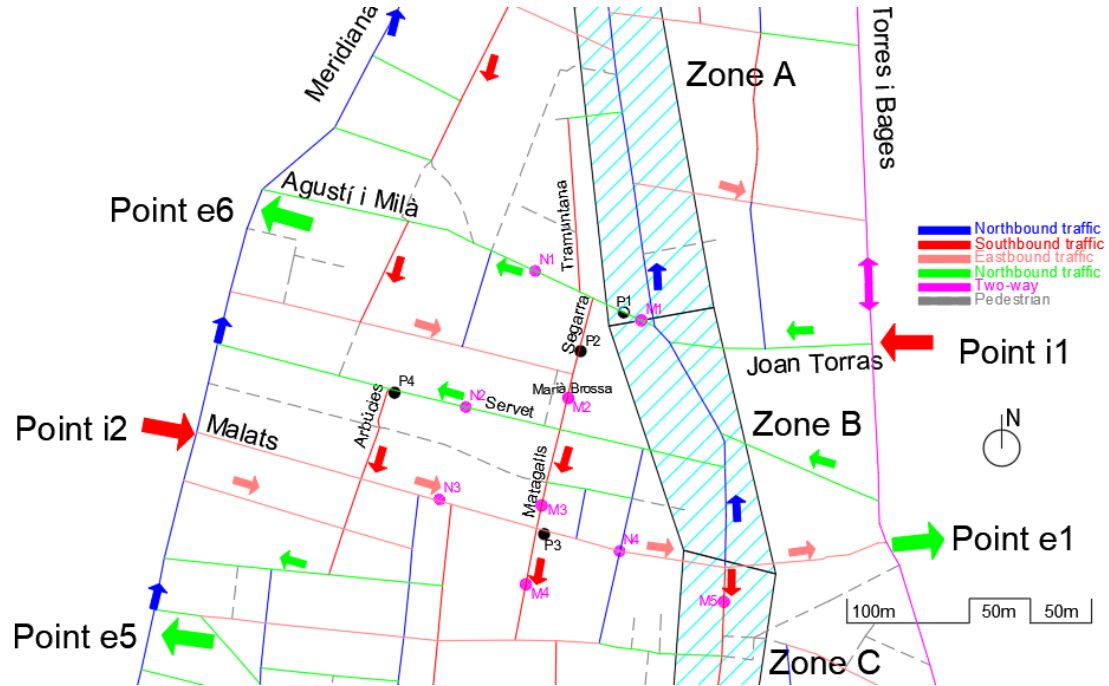
Figure 6. Area of study, with the locations of the four measurement points.